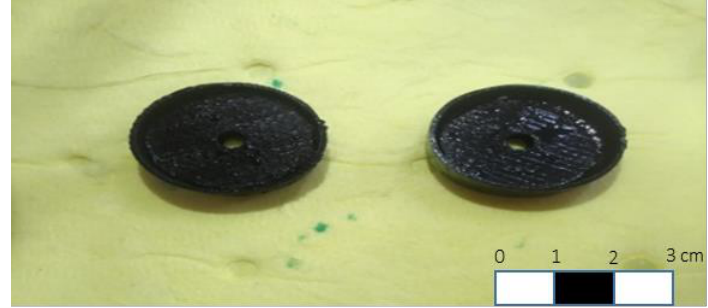
Figure 5. After immersing into the electrolyte.